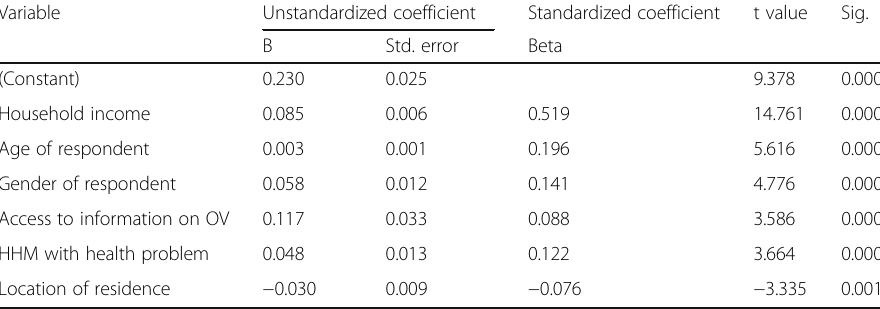
Table 6 Coefficients of Variables of factors influencing consumers ’ perception of health benefits of organic vegetables using Stepwise Multiple Linear Regression Model